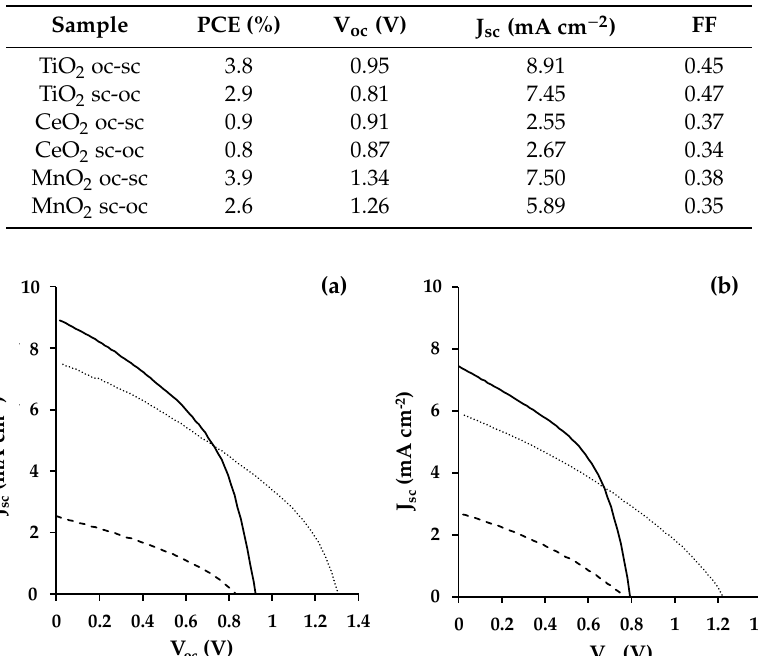
Table 1. I-V data for CH 3 NH 3 PbBr 3 PSC devices with mesoporous films sintered at 550 ◦ C. The direction Table 1. I ‐ V data for CH 3 NH 3 PbBr 3 PSC devices with mesoporous films sintered at 550 °C. The of voltage sweep is shown as oc-sc = open circuit to short circuit and vice versa. direction of voltage sweep is shown as oc ‐ sc = open circuit to short circuit and vice versa .